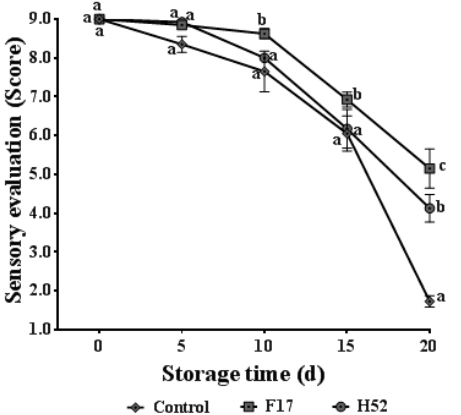
Figure 5. Changes in sensory evaluation of table grapes with different treatments during storage at 25 °C. Each point is the average and standard deviation of four replicates. Different lowercase letters at the same storage time indicate a significant difference ( p < 0.05).